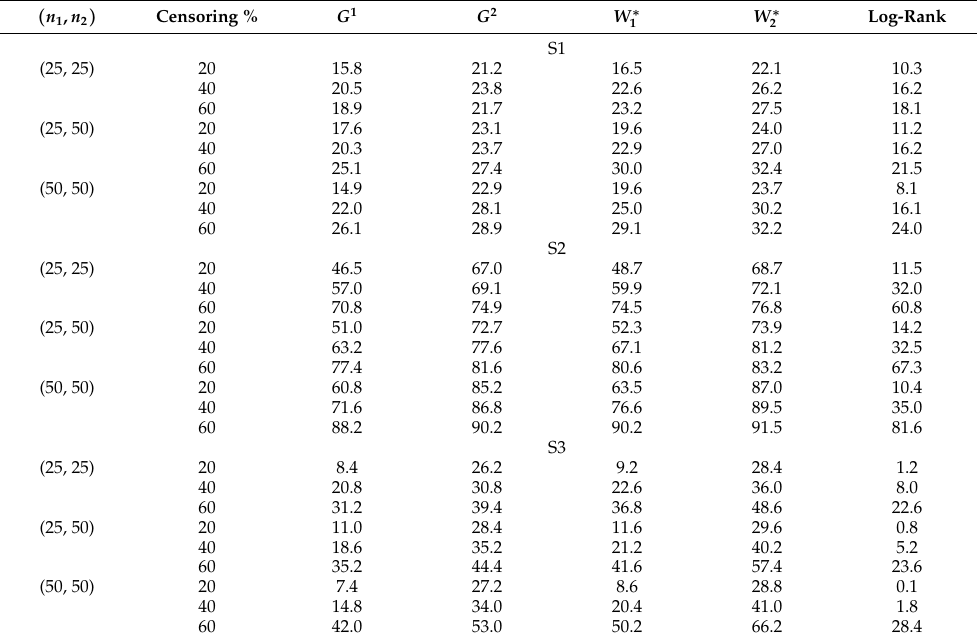
Figure 2. Configurations for crossing survival curves. Table 3. Power simulation results